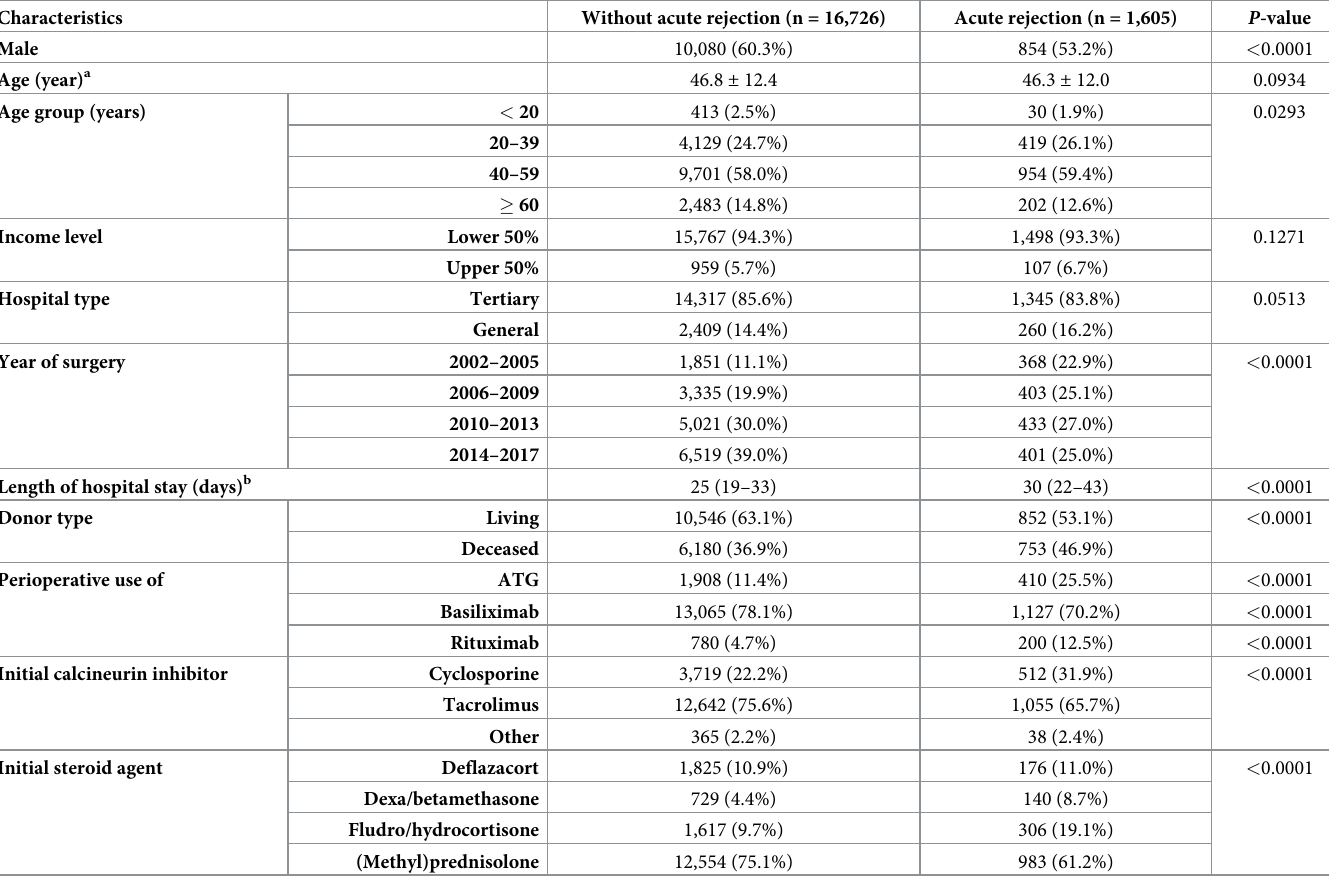
Values are indicated as number (percentage) unless indicated otherwise. ATG, antithymocyte globulin. a Values are mean ± standard deviation. b Values are median and 1st to 3rd